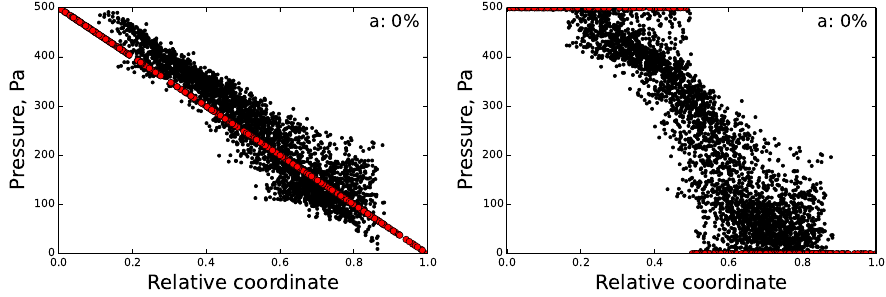
Figure 10. Pressure values depending on coordinate. ( left ) for gradient boundary conditions; ( right ) for constant boundary conditions. Boundary points are highlighted in